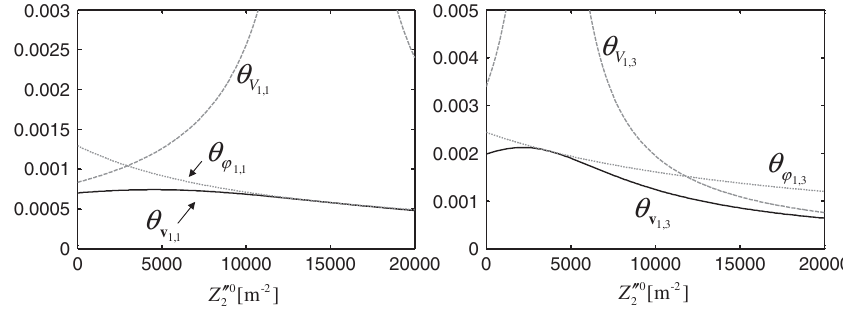
FIG. 8. The rf tolerances in accelerating module M